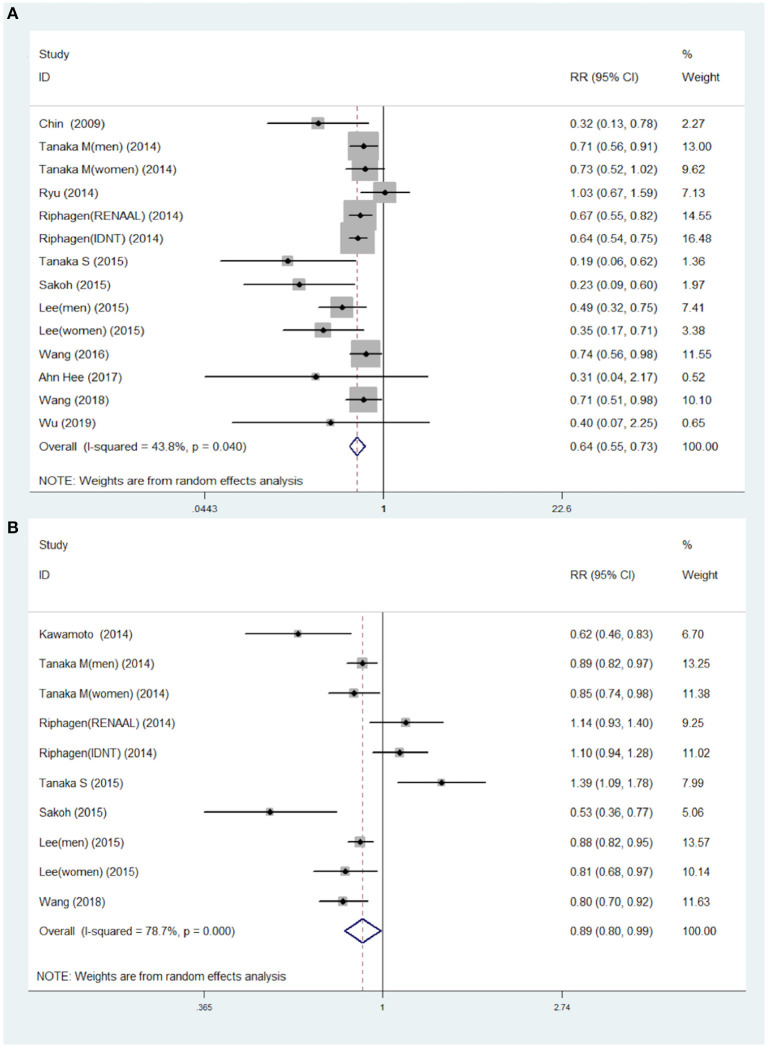
Pooled RR with 95% CIs for the association of serum total bilirubin levels and the risk of CKD for the highest compared to the lowest category group (A) and for each 0.2 mg/dl increase (B). The random-effects model was used and the area of each square stands for the weight of each study in the meta-analysis. The square sizes are proportional to the weight of each study in the meta-analysis; the diamond shows the overall RR; the horizontal lines indicate the 95% confidence intervals (CIs). CKD, chronic kidney diseases; RR, risk ratio.